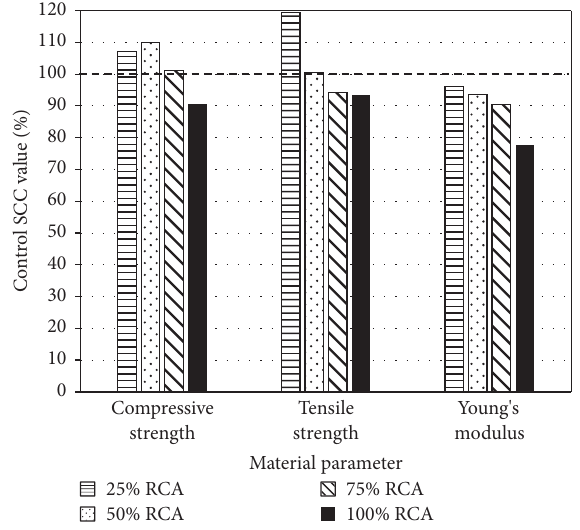
Figure 6: Relative comparison of RCA and control concrete strength